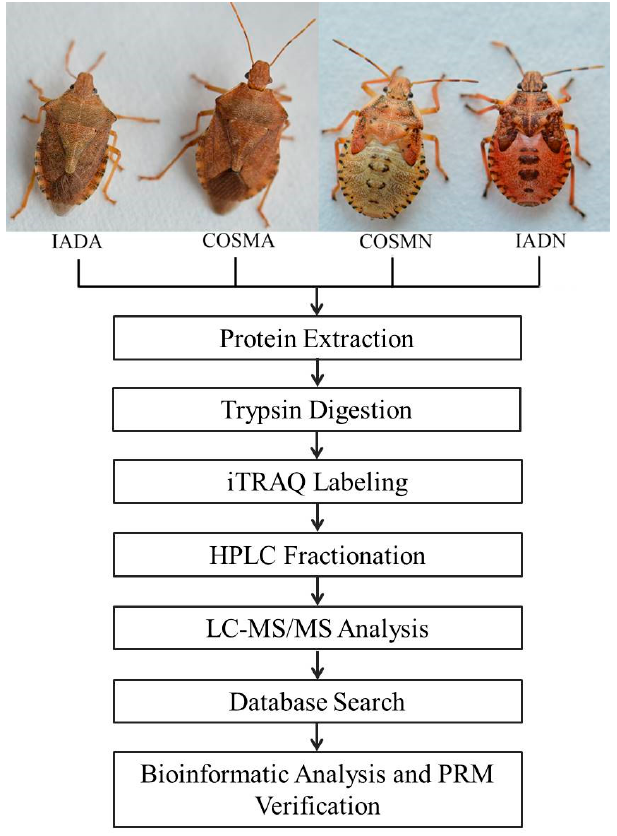
Figure 1. Overview of experimental procedures used in this study: (IADA) Adults of Arma chinensis reared on improved artificial diet; (COSMA) Adults of Arma chinensis reared on Chinese oak silk moth Antheraea pernyi pupae; (COSMN) Nymphs of Arma chinensis reared on Chinese oak silk moth Antheraea pernyi pupae; (IADN) Nymphs of Arma chinensis reared on improved artificial diet.